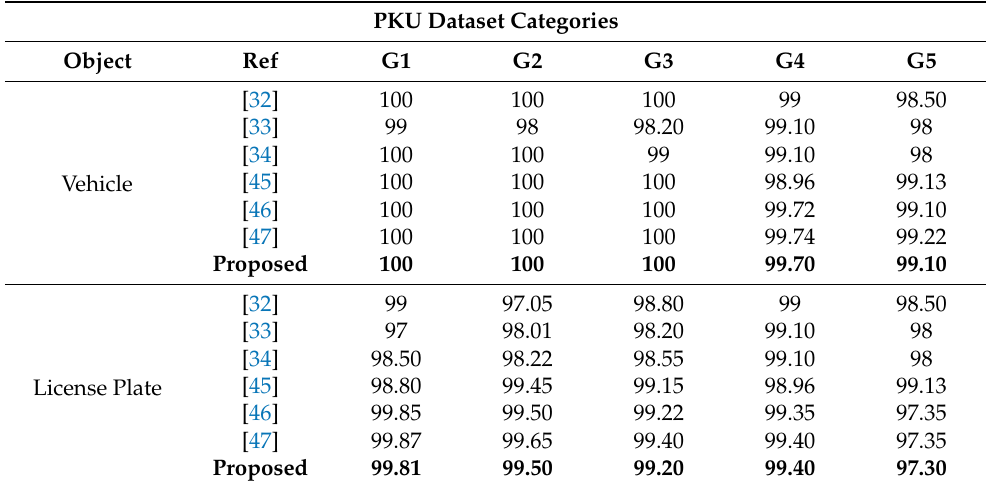
Table 2. Category-wise Vehicle + License Plate detection comparison (%) on PKU